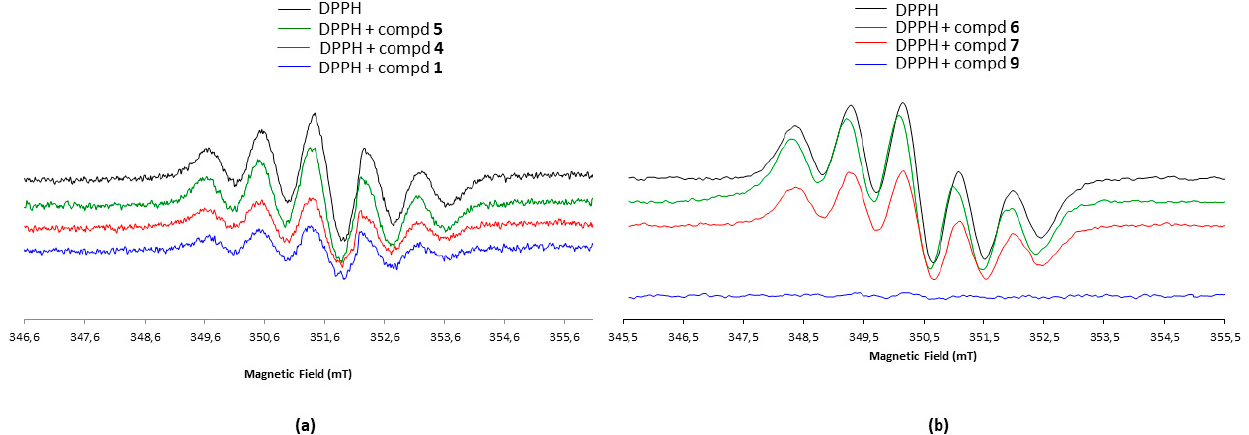
Figure 2. Room temperature (298 K) EPR spectra at X-band of DPPH radical before (black line) and after the addition of each compound. ( a ) compound 5 (green line), compound 4 (red line) and compound 1 (blue line); ( b ) compound 6 (green line), compound 7 (red line) and compound 9 (blue line). Experimental conditions: ν = 9.86 GHz microwave frequency, 2 mW microwave power, 0.1 mT modulation